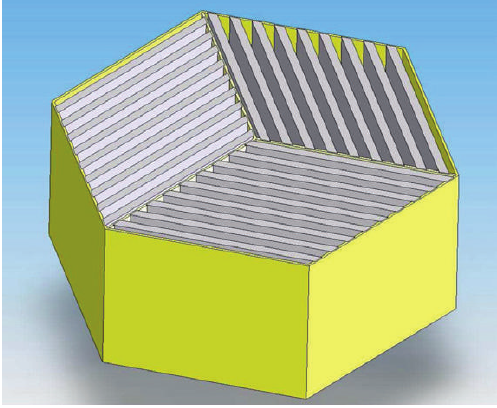
Figure 9: Fuel assembly of Gen IV